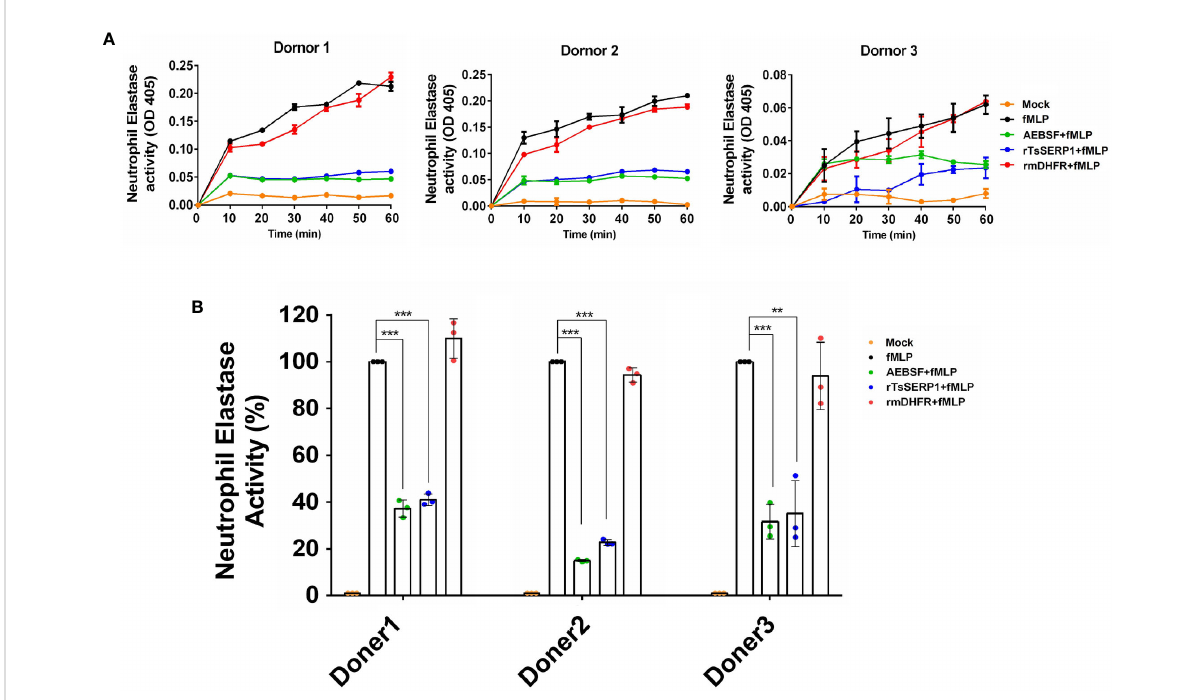
FIGURE 2 The neutrophil-secreted elastase activity inhibited by rTsSERP1. Neutrophils were induced with 100 nM of fMLP prior to treatment with 40 µM of rTsSERP1or an irrelevant control (rmDHFR) followed by detecting NE activity using a neutrophil elastase substrate for 1 h (A) and the percentage of the NE activity was calculated at 1h by setting neutrophils treated with fMLP alone as 100% activity (B) . Media alone was used as a negative control and 0.1 mM of 4-(2-aminoethyl) benzenesulfonyl fl uoride hydrochloride (AEBSF) was used as a positive control for serine protease inhibition. The bar charts show the data of three different donors, which are presented as the mean ± SD. The experiments were performed in triplicate with three independent experiments. One-way ANOVA followed by a Bonferroni multiple comparison test were used for statistical analysis: ** p < 0.01 and *** p < 0.001. The treatment conditions were included media alone (Mock), only fMLP induction (fMLP), fMLP induction and AEBSF treatment (AEBSF+fMLP), fMLP induction and rTsSERP1 treatment (rTsSERP1+fMLP), fMLP induction and irrelevant control (rmDHFR) treatment